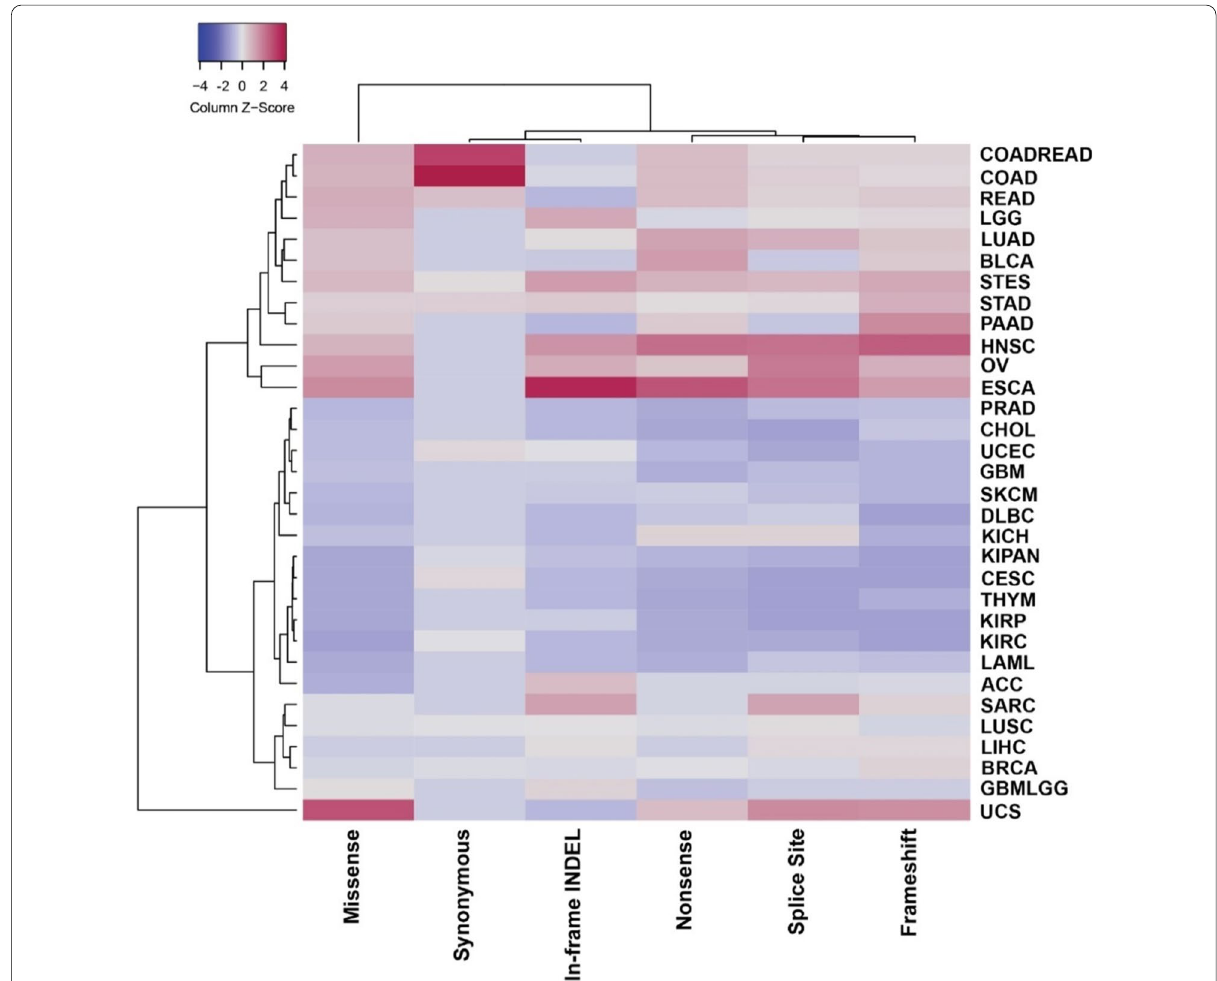
Fig. 5 Mutational spectrum analysis of 33 cancer